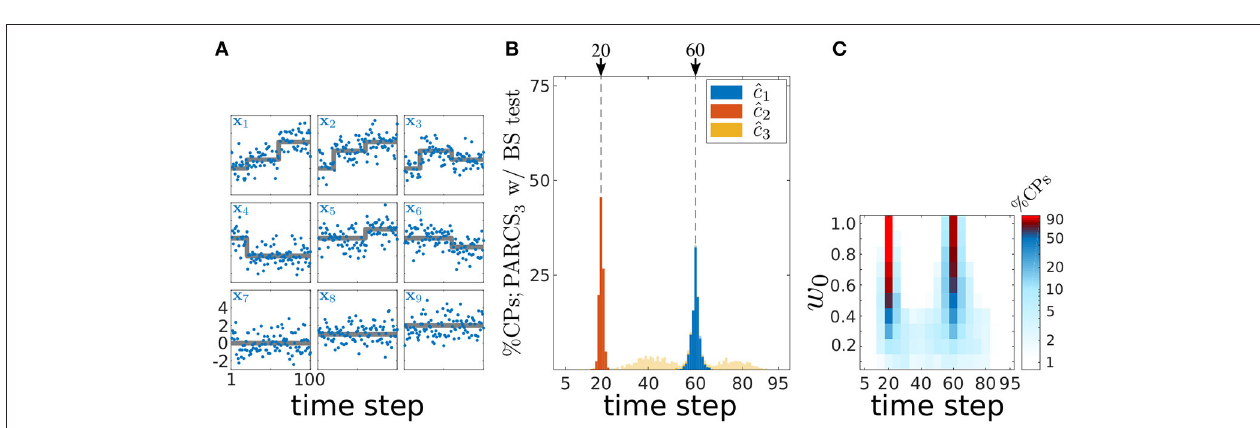
FIGURE 6 | Multiple CP detection in temporally dependent data from the second scenario; (A) estimating MA order; (top) average autocorrelation over time series realizations for different time lags ± s.d.; dashed gray, 95% confidence interval; (bottom) ratio of 1,000 realizations with a given estimated order; (B) stacked histograms of correct detection rates over 1,000 realizations; transparent bars show candidate CPs excluded by the permutation test; dashed gray, ground truth CPs; inset, deterministic component of time series; (C) deterministic component of the time series (gray) superimposed on an exemplary time series (blue); bottom shows a close up over 16 data points around c 1 ; red line highlights oscillation due to the negative MA coefficient.